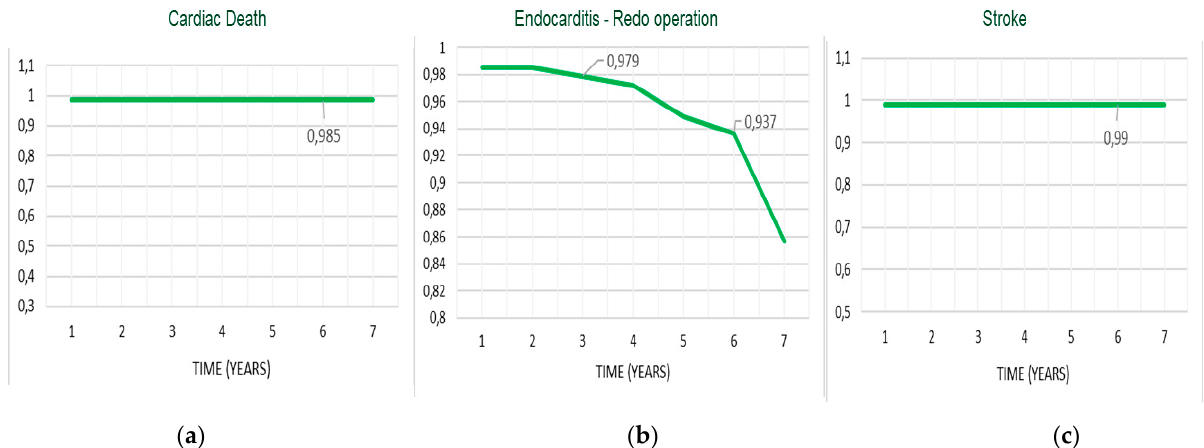
( c ) Figure 4. Survival stratified by biological vs. mechanical prostheses ( a ); concomitant CABG ( b ); presence of previous MI ( c ) (log rank, Mantel–Cox test). CABG: coronary artery bypass grafting; MI: myocardial infarction.